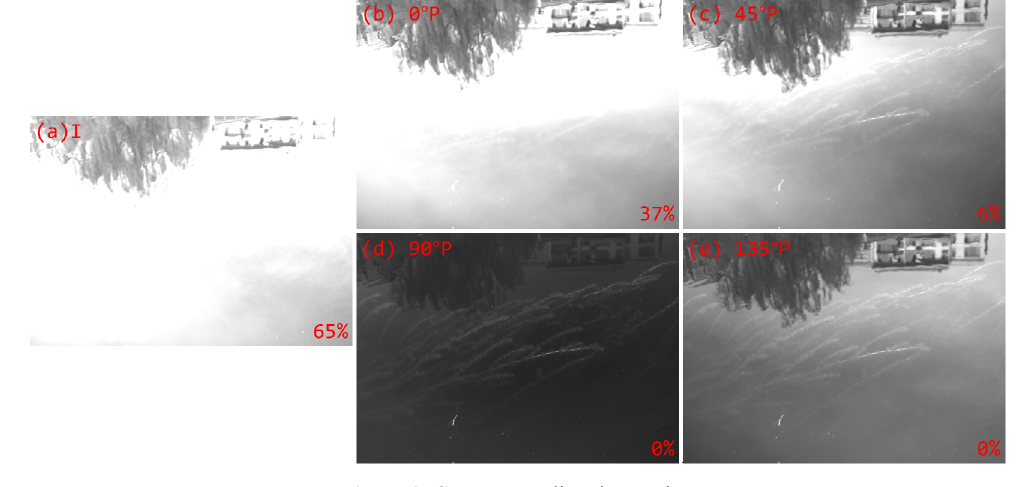
Figure 2. Case Ⅰ : sun-glint observation